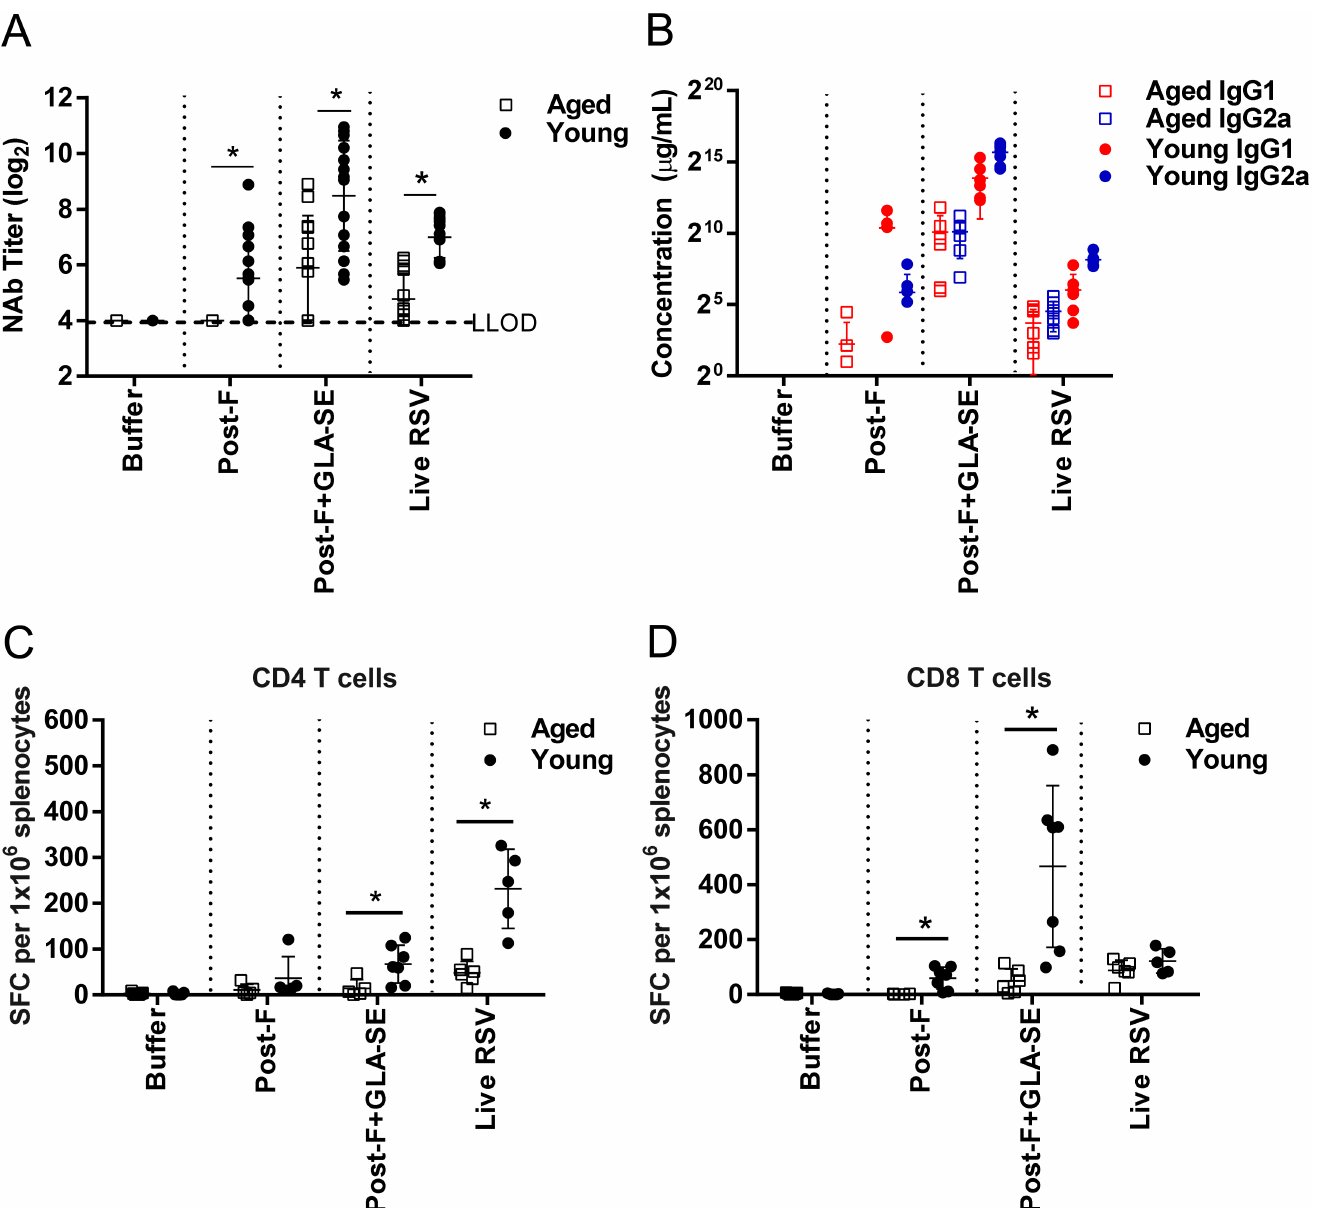
Fig 1. Immunogenicity of post- RSV F formulations in young and old seronegative mice. Young (7 weeks old) and aged (18 months old) BALB/c mice (n = 4 to 7 per group) were immunizedi.m. at day 0 and day 21 with buffer alone, post-F (0.3 μ g) +/- GLA-SE (2.5 μ g/2%) adjuvant. A control group for natural infection was immunized i.n. with live RSV (10 6 PFU) at day 0. At day 35, animalswere challengedi.n. with 10 6 PFU of wt RSV A2. (A) Prior to challenge(day 34), sera were harvestedand NAb titers were evaluatedusing a microneutralization assay. Data is presented as the log 2 dilutionof serum that provides50% reductionin viral entry with a LLOD of 4 indicatedby a dashed line. At sacrifice (day 39), (B) RSV F specific anti-IgG1 and anti-IgG2a were measuredby ELISA, and splenocyteswere isolated and stimulated for 24 h with peptides representing(C) RSV F specific CD4 T-cell and (D) CD8 T cell epitopes.The number of IFN γ secretingcells per 10 6 splenocyteswas determined by ELISPOT. Group means ± SD of individual mice are shown. For statistical analyses, agedand young mice were compared. * , P < 0.05.